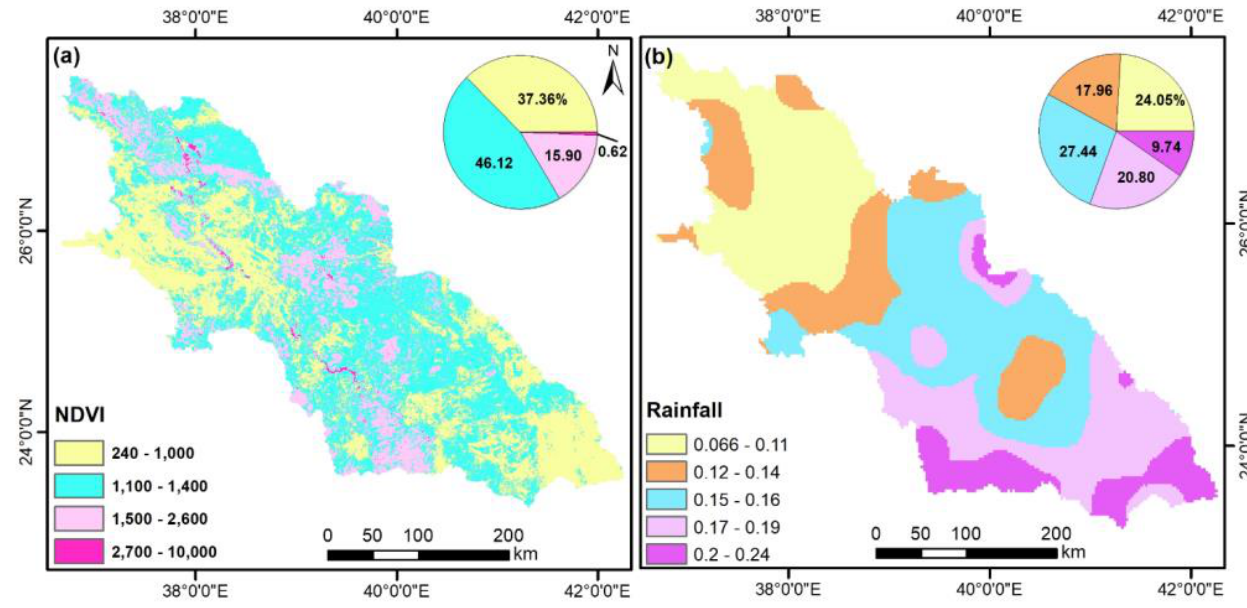
Figure 6. Ecologic and climatic factors; ( a ) NDVI distribution; ( b ) rainfall intensity.